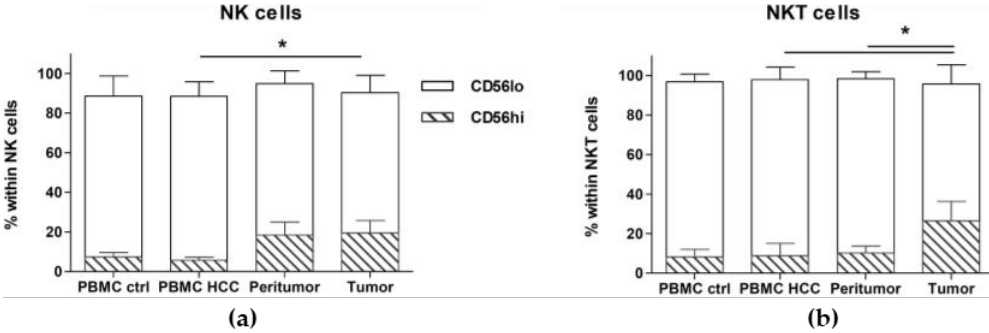
Figure 2. Decreased frequencies of CD56low NK and NKT cells in tumors. Cell suspensions